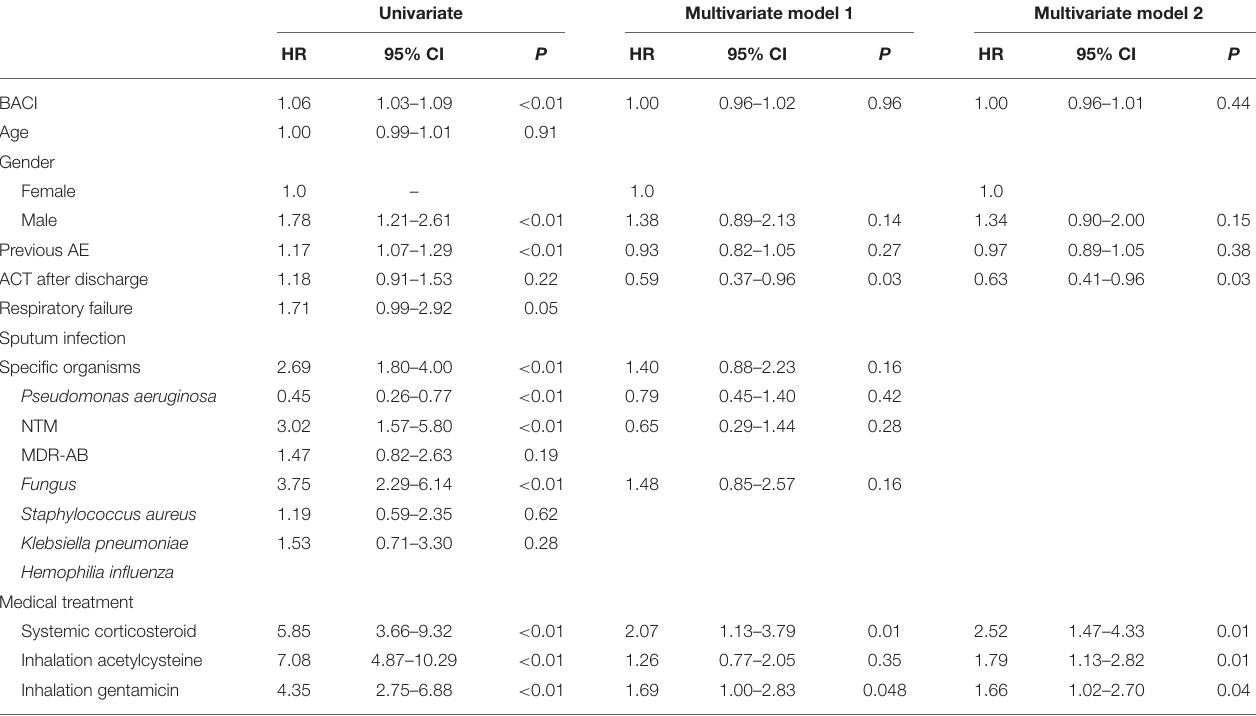
TABLE 5 | Univariate and multivariate analysis of 1-year respiratory failure.